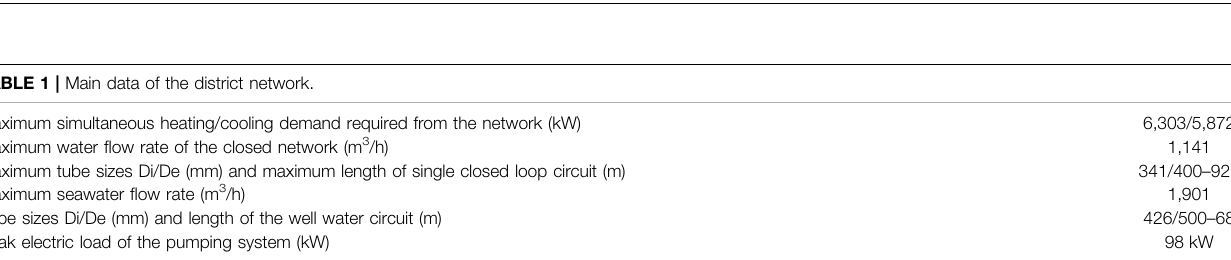
TABLE 1 | Main data of the district